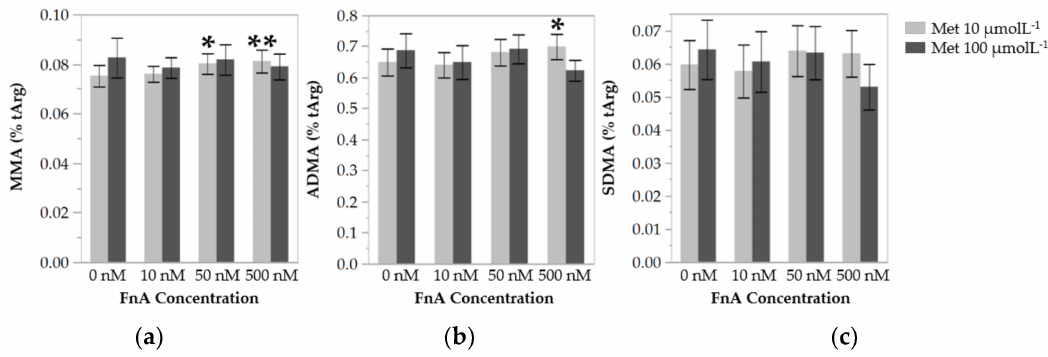
Figure 3. Concentrations of protein-incorporated N G -monomethylarginine (MMA) ( a ), asymmetric N G , N G -dimethylarginine (ADMA) ( b ), and symmetric N G , N (cid:48) G -dimethylarginine (SDMA) ( c ) in HUVECs after 48 h of incubation with increasing concentrations of folinic acid (FnA), with methionine (Met) at 10 µ mol L − 1 or 100 µ mol L − 1 . Values are mean ± SE, are expressed as fraction of total arginine content, and represent 5–9 independent experiments with HUVECs from individual donors. Statistical significance of the effect of the increasing concentrations of FnA was determined using